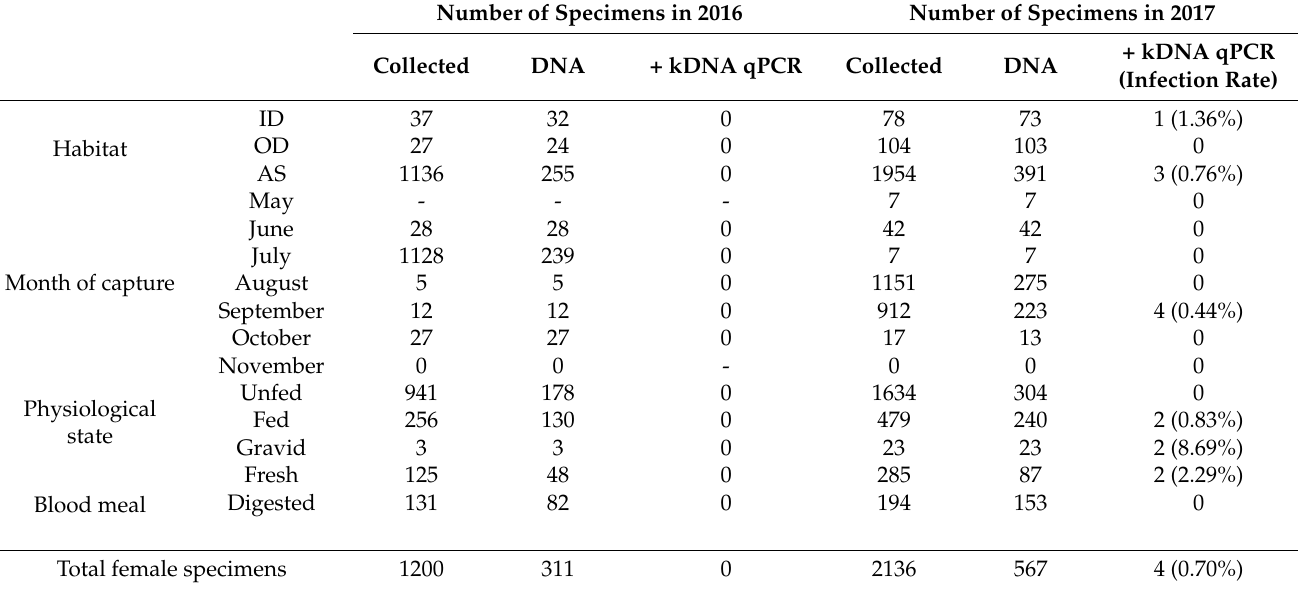
Table 4. Number of infected specimens according to habitat, physiological state, and month and year of capture.